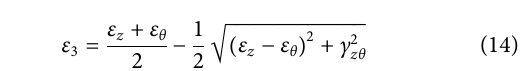
Frontiers in Earth Science |